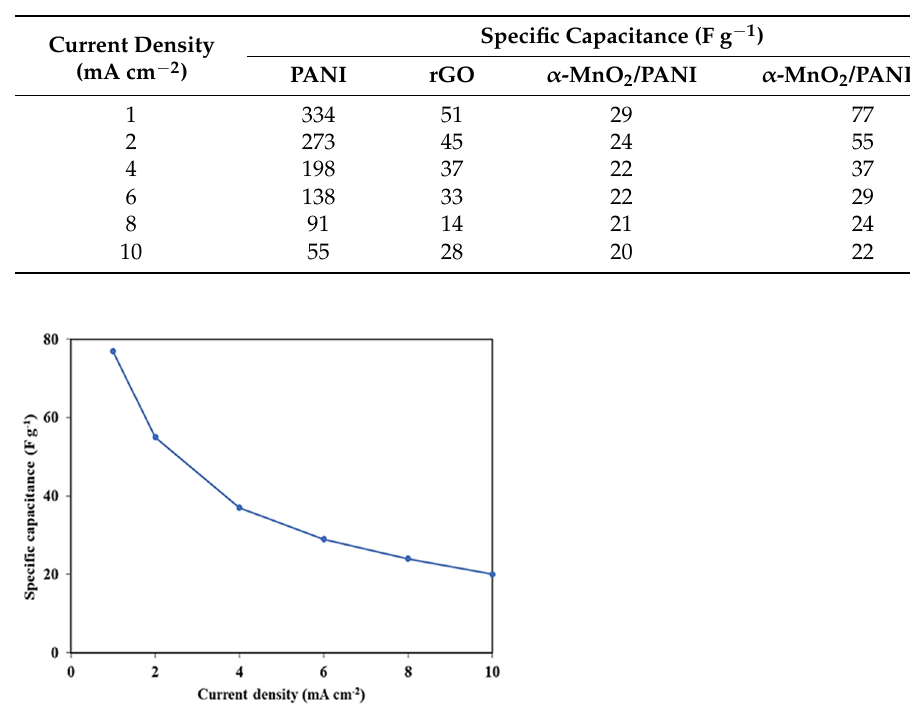
Table 2. Specific capacitance values calculated from GCD.